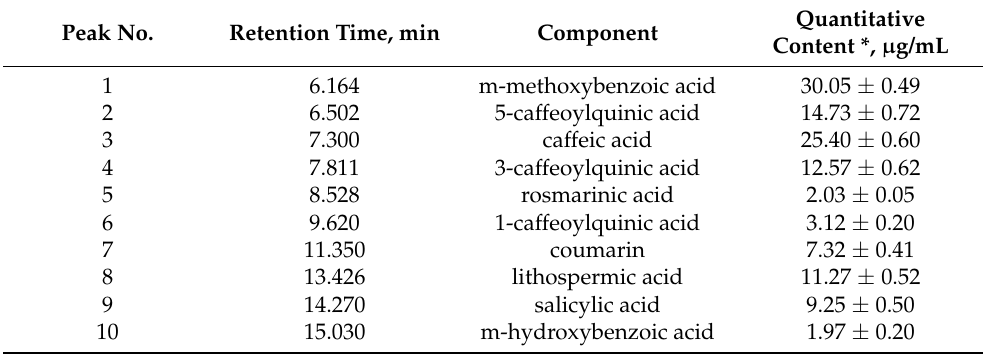
Table 2. Component composition of the aqueous-alcoholic extract of Symphytum officinale , containing type I polymer, according to HPLC data. Peak